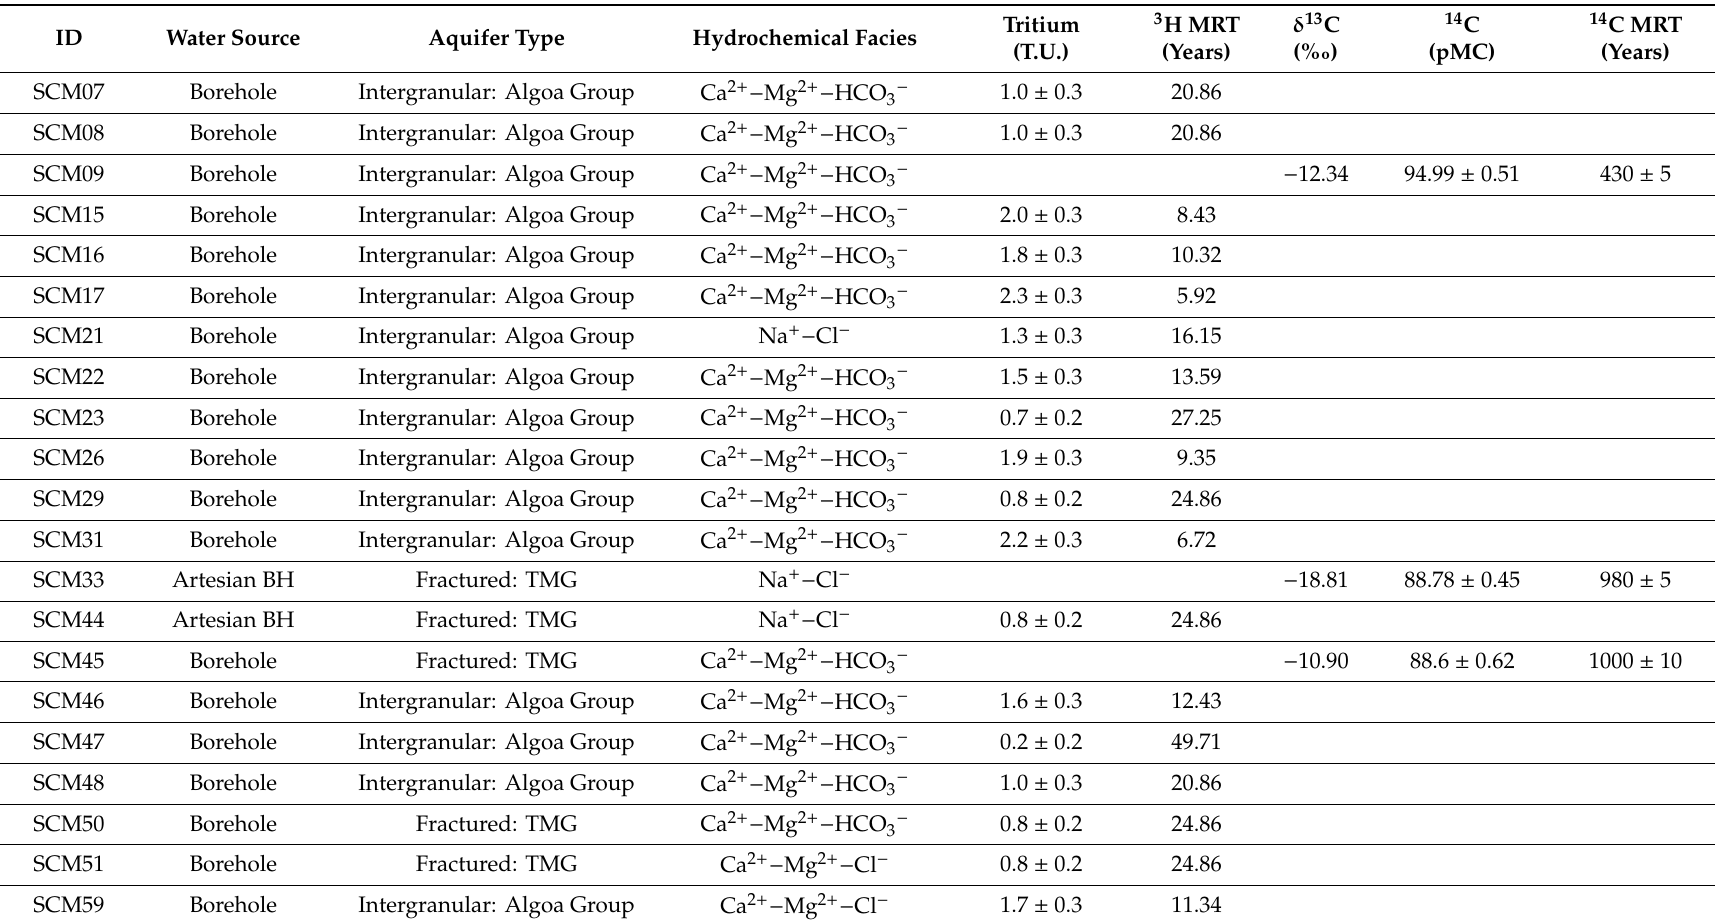
Table 5. Groundwater residence times estimated from 3 H and 14 C